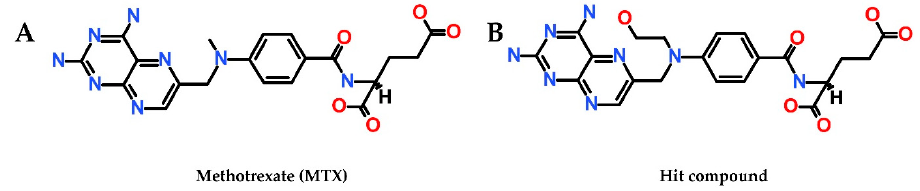
Figure 8. ( A ) 2D structure of MTX ( B ) 2D structure of Hit compound (MTX analog, ZINC ID: ZINC000013508844).